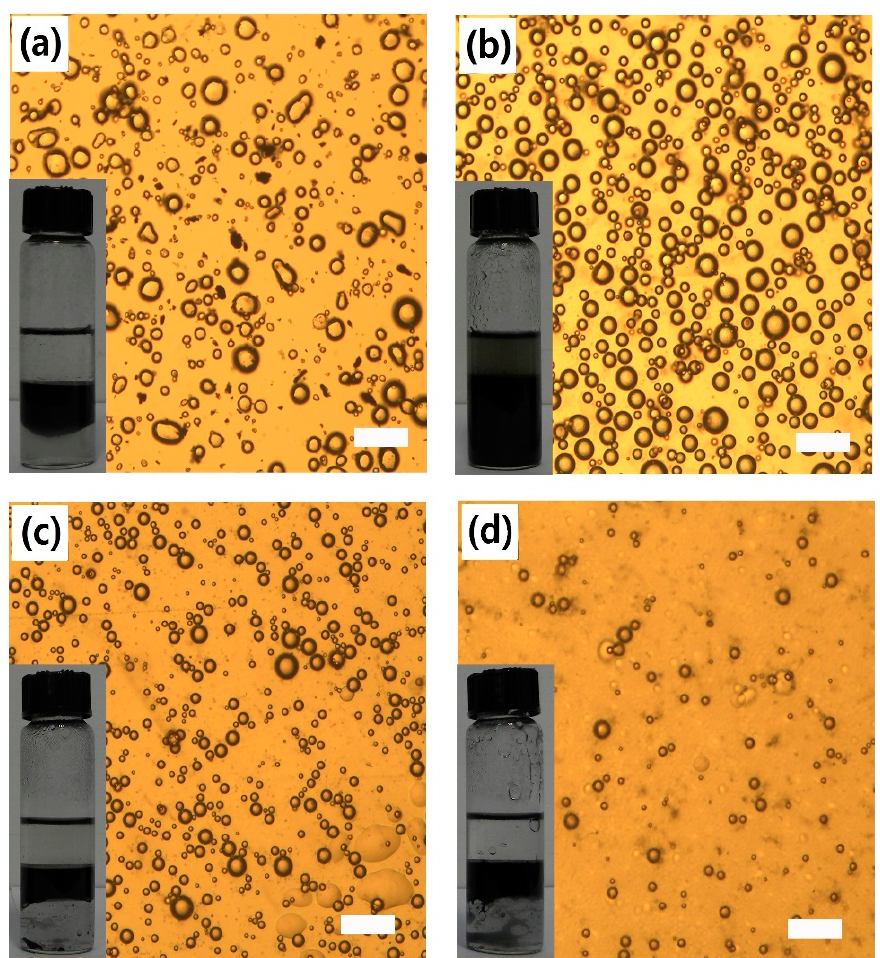
Figure 5. Optical micrographs and photographs after 72 h preparation of Pickering emulsions stabilized by AmGO: ( a ) AmGO18-0.5; ( b ) AmGO18-1; ( c ) AmGO18-2 and ( d ) AmGO18-4. AmGO concentration: 1 mg/mL. Toluene/water ratio: 1:1. Scale bar: 100 µ m.